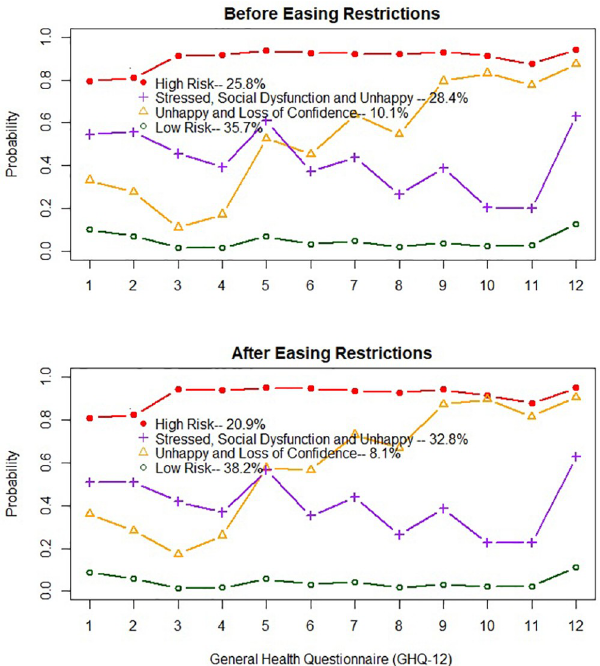
Fig 1. Profile of mental health problems. 1. Unable to concentrate; 2. Loss of sleep; 3. Play much less useful part; 4. Unable to make decisions; 5. Under strain; 6. Couldn’t overcome difficulties; 7. Unable to enjoy 8. Unable to face up problems; 9. Unhappy and depressed; 10. Lose confidence; 11. Worthless person; 12. Feel unhappy. https://doi.org/10.1371/journal.pone.0255251.g001 Table 1. Prevalence of mental health problems by characteristic—Before easing COVID-19 restrictions (N = 46508).